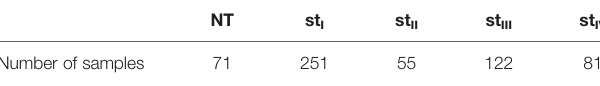
TABLE 1 | Number of harmonized cases for each stage of ccRC and NT.